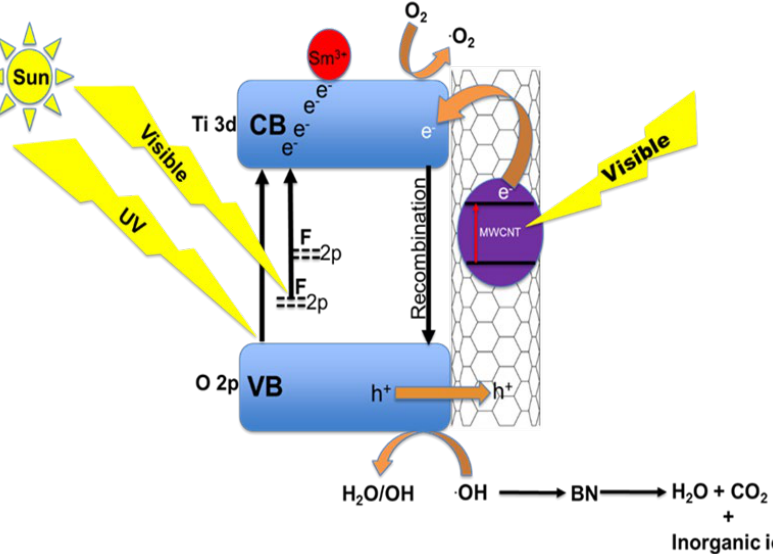
3+ doping on TiO 2 -MWCNT hybrid